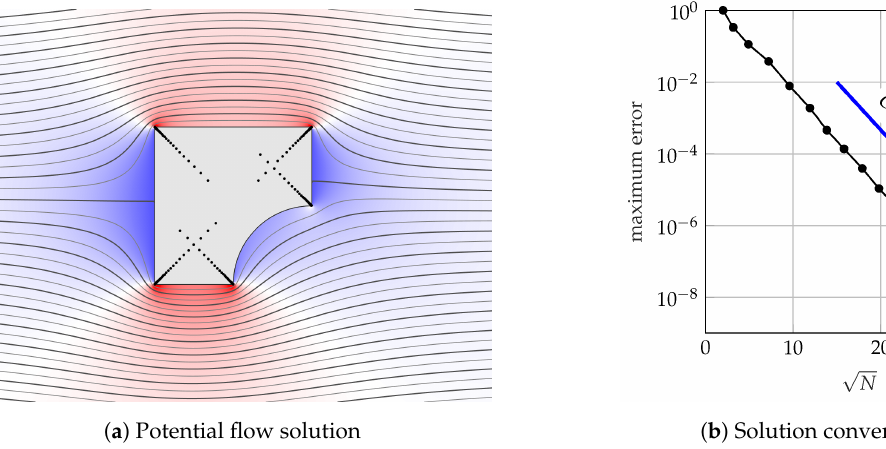
Figure 1. Incompressible, irrotational (i.e., potential) flow past a square circular sector removed. The problem takes 0.5 s to solve to six digits of accuracy and 5 s for eight digits. In ( a ) the black dots represent the poles. The background colour in ( a ) represents the horizontal velocity of the perturbation to the flow from uniformity. Note that in ( b ) the y -axis is on a log scale whereas the x -axis is √ N , so that a straight line indicates root-exponential